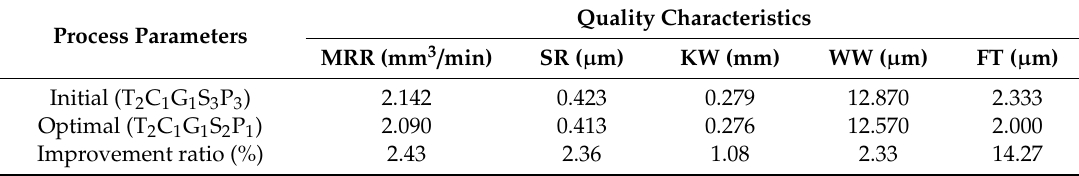
Table 8. Results of the confirmation test for multiple quality characteristics using the initial and the optimal process